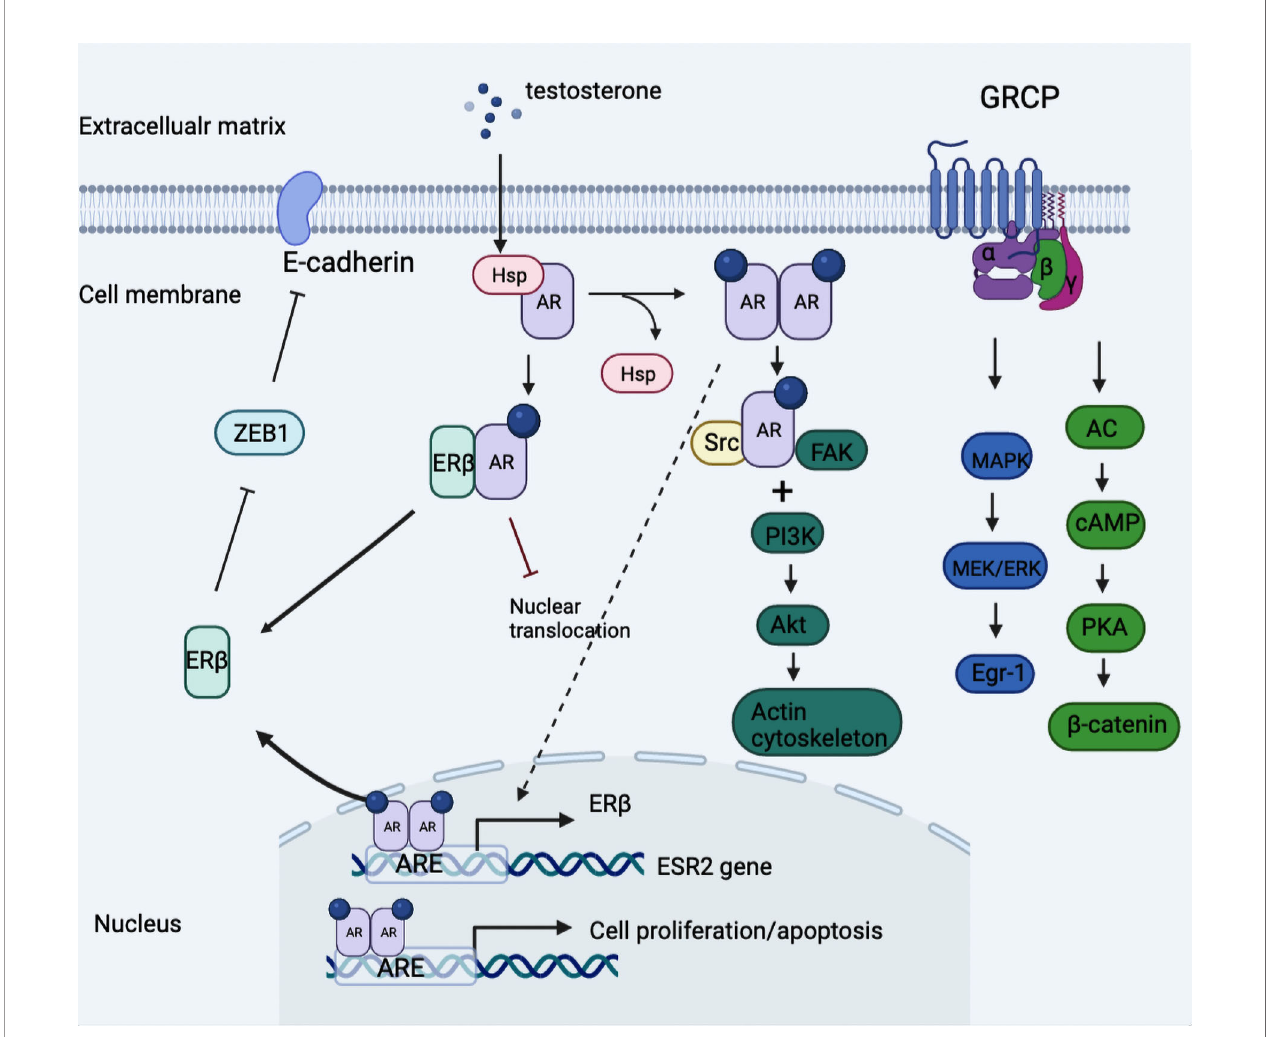
FIGURE 2 | Model of androgen-induced genomic and non-genomic actions in TNBC cells. Classical AR was divorced from the HSP and formed the homodimer once activated by a ligand, which was then transferred into nuclear actions and binding to the promotor of ESR2 gene linked to regulation of ER b expression. Further, the expressed ER b dimerized with AR then impeded the nuclear translocation of AR-AR homodimer and thus blocked downstream oncogenic signaling. In addition, androgen stimulation activated the classical AR/Src complex assembly, rapidly recruiting PI3K and FAK, which triggered the downstream phosphorylation and the consequent cytoskeleton changes. Besides, the G protein-coupled form of AR activated downstream MAPK/MEK/ERK signaling and induced the phosphorylation of cAMP and PKA. ARE, androgen receptor element; Egr-1, early growth response 1; GRCP, G protein coupled receptor; HSP, heat shock protein; ZEB1, zinc fi nger E-box binding homeobox